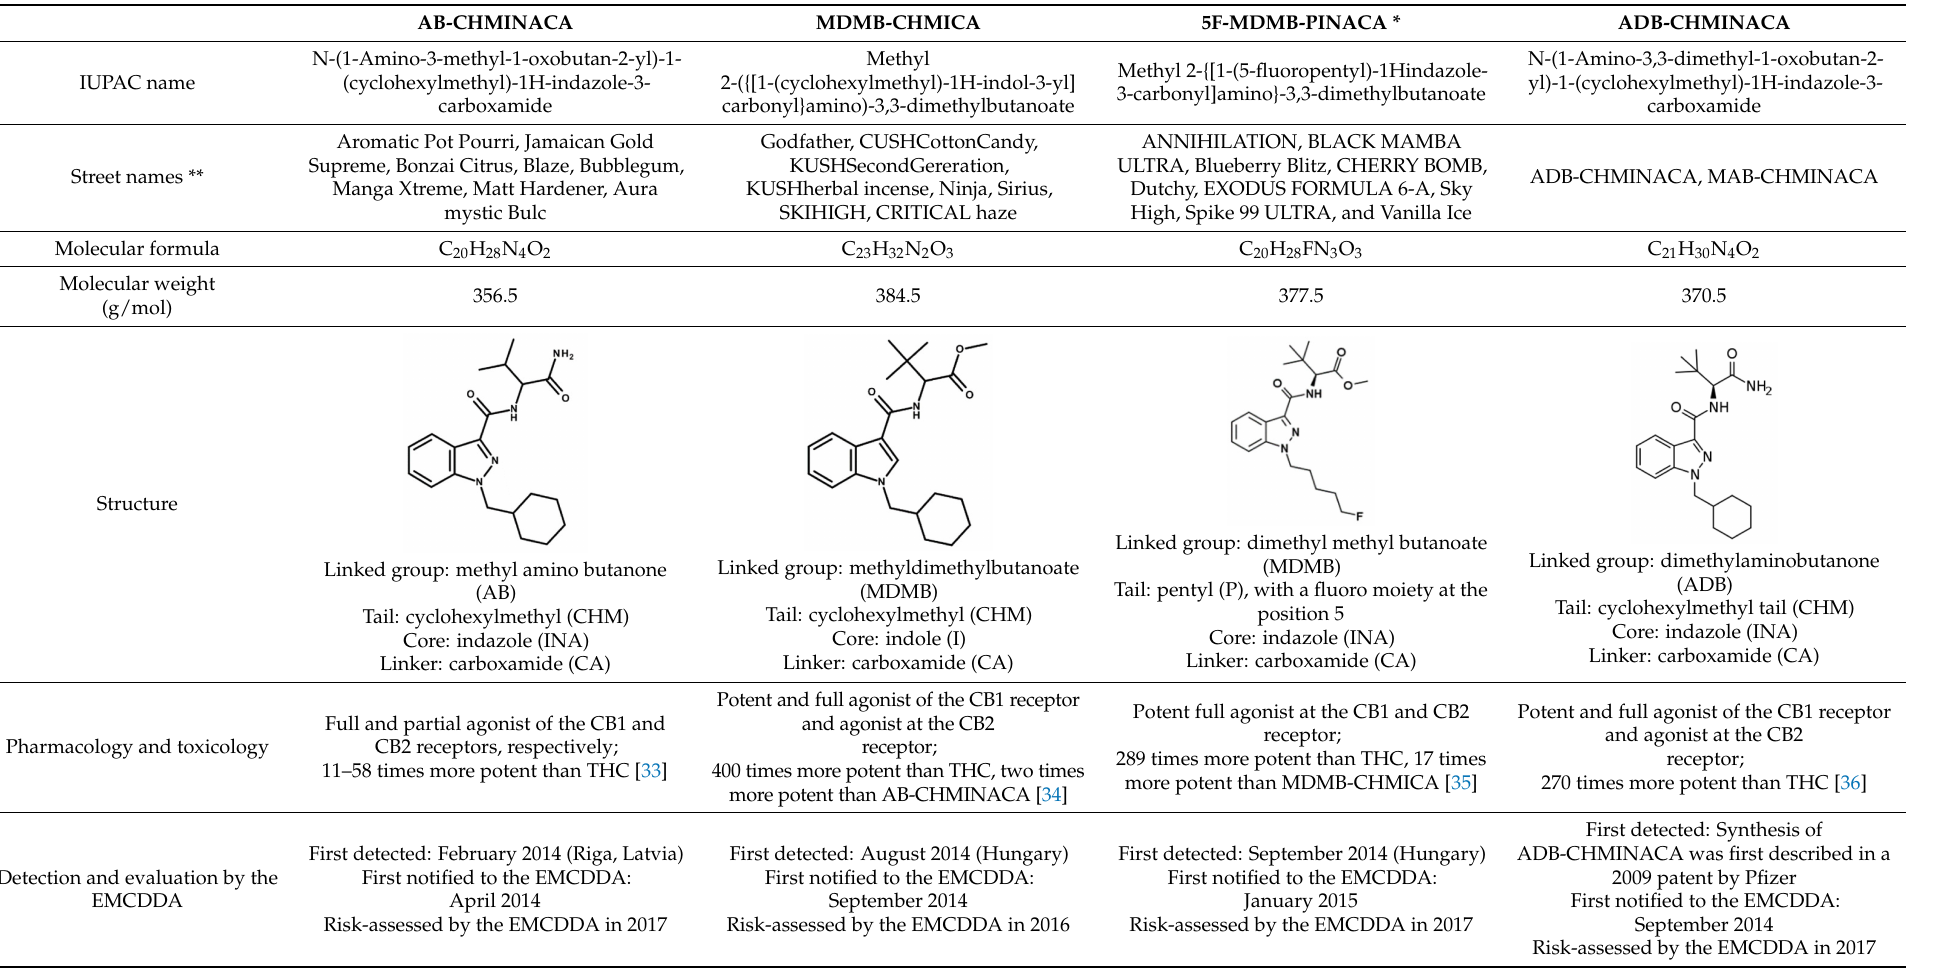
Table 1. Nomenclature, structure, and characteristics of the four synthetic cannabinoids included in this